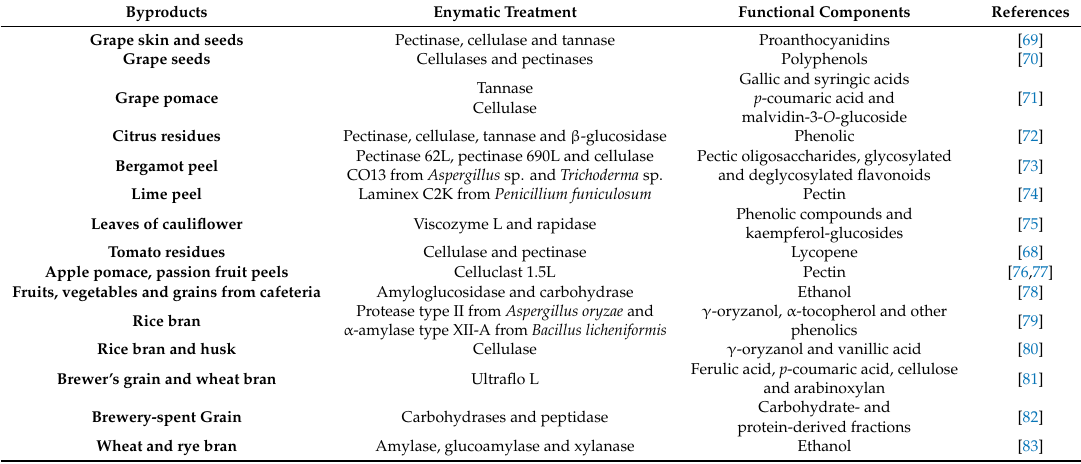
Table 3. Enzymatic treatments on fruit, vegetable and cereal byproducts for the recovery of main bioactive